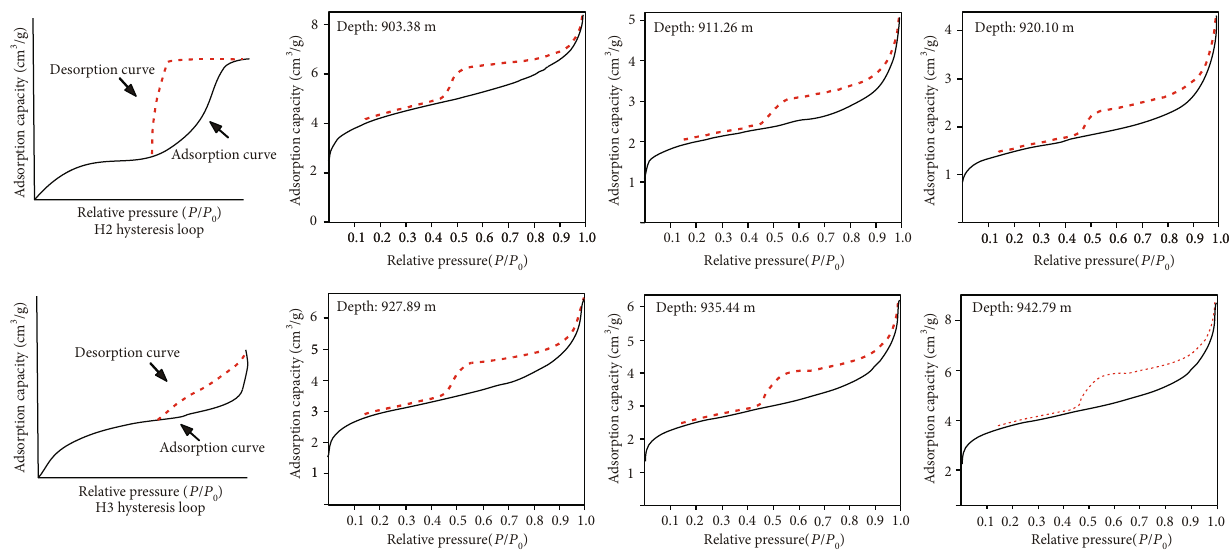
Figure 6: Characteristics of the N adsorption and desorption at low temperatures in the Longmaxi Formation. 2